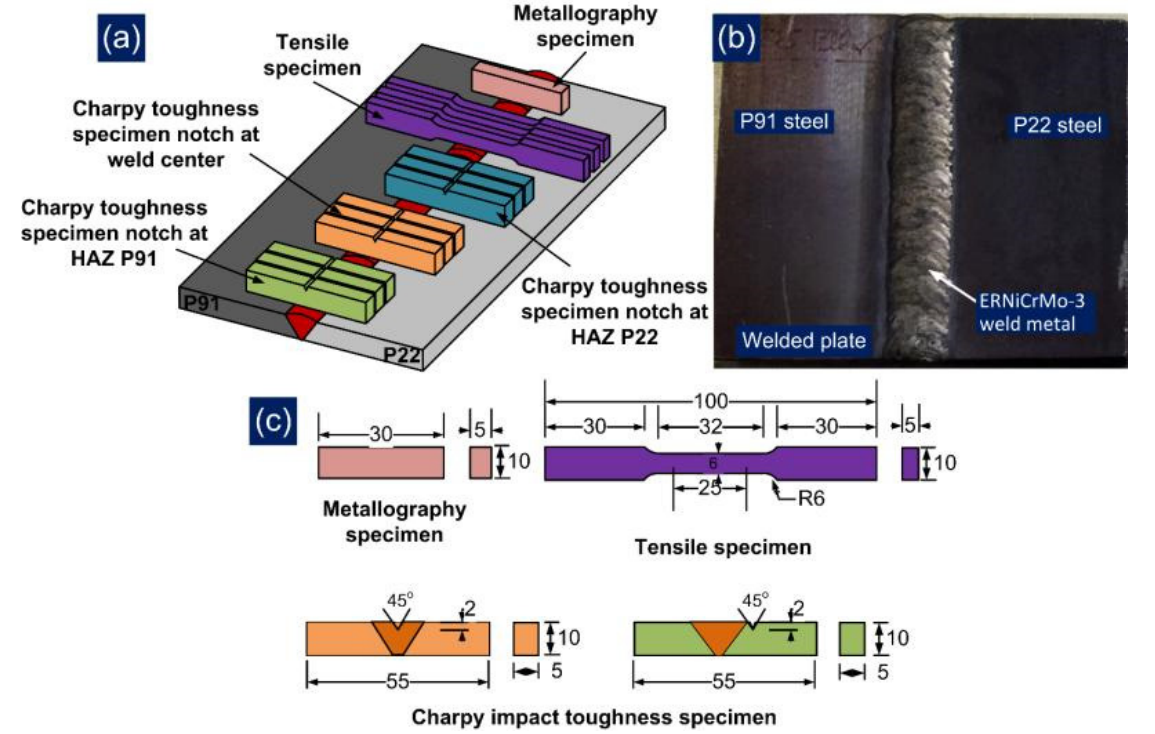
Figure 3. ( a ) Schematic image showing the extraction of the specimen from a welded plate, ( b ) view of welded plate, ( c ) dimensions of the testing specimens.